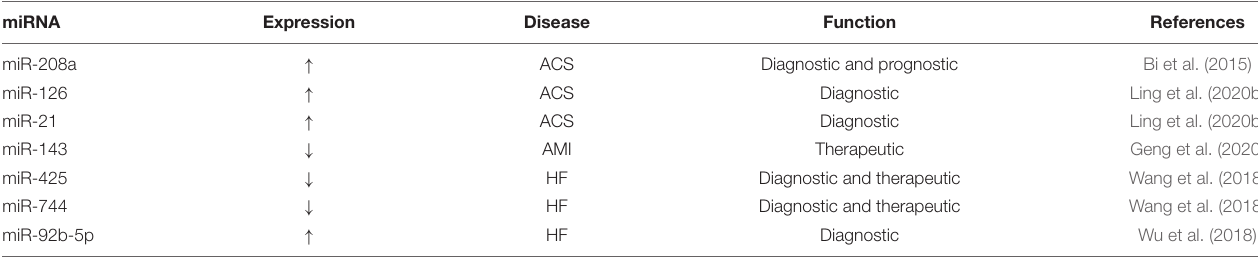
TABLE 2 | The role of serum exosomal miRNAs in cardiovascular disease.